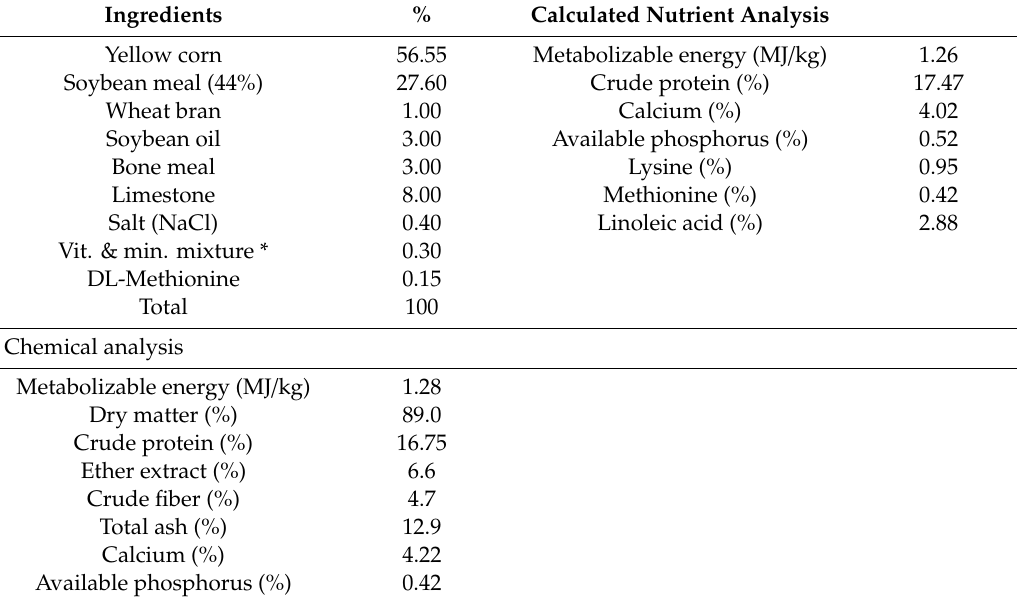
Table 1. The ingredients and calculated nutrient analysis as well as the determined chemical analysis of the basal